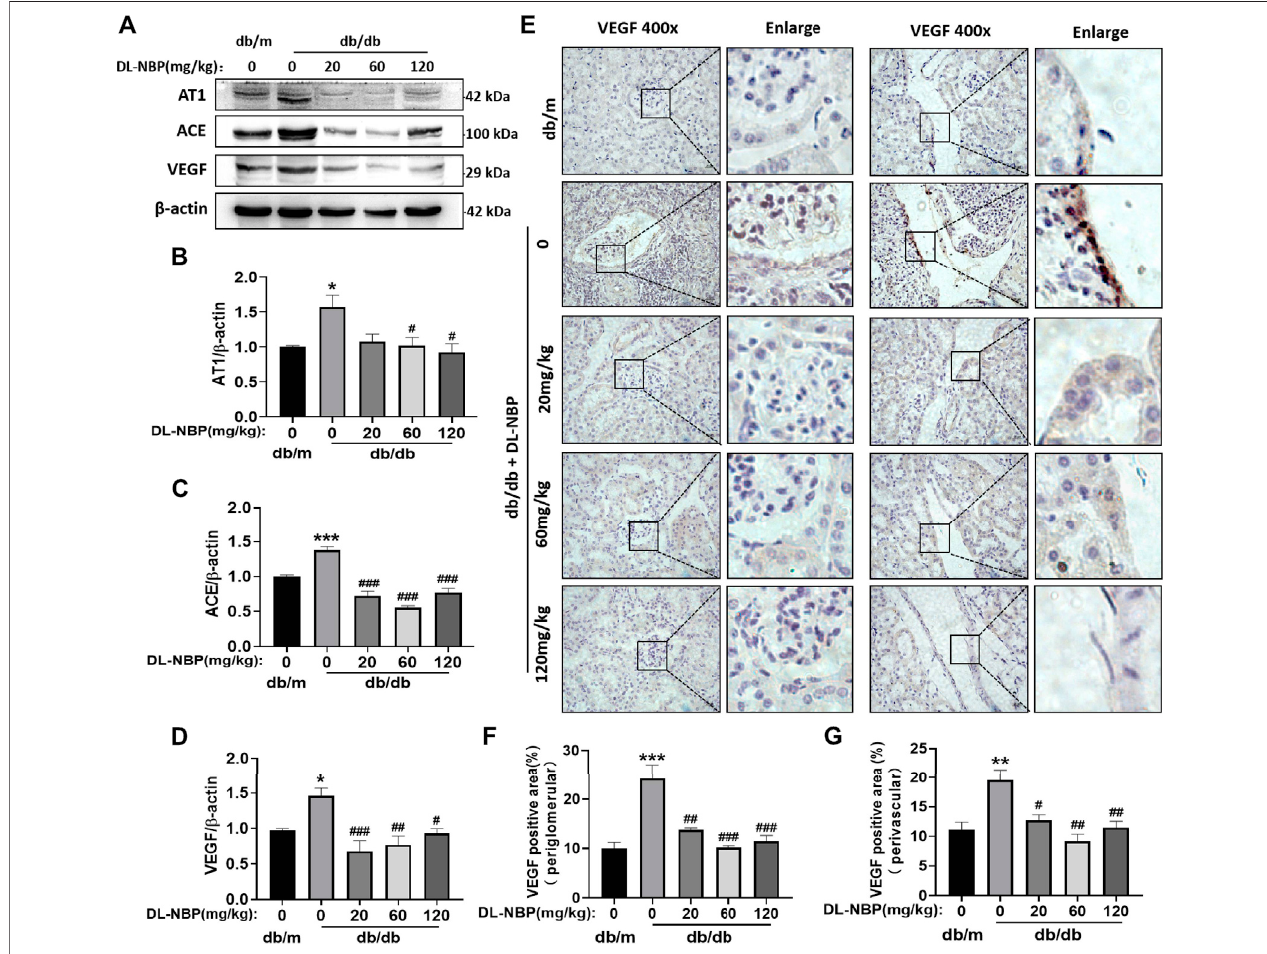
FIGURE 7 | DL-NBP restores the function of RAS and blocks VEGF overexpression. (A – D) Western blotting and quanti fi cation analysis of AT1, ACE, and VEGF in kidney of mice from each group ( n (cid:2) 3). Protein expression was normalized to the expression of β -actin. (E – G) Immunohistochemical staining of VEGF (brown positive point) inkidney ofmice fromeach group(original magni fi cation × 400) ( n (cid:2) 3). Scalebar (cid:2) 20 μ m.Dataare presented asmean ± SEM; * p < 0.05, ** p < 0.01, *** p < 0.001 vs. db/m control; # p < 0.05, ## p < 0.01, ### p < 0.001 vs . db/db mice. AT1, angiotensin II-related proteins angiotensin II receptor type 1; ACE, angiotensin II generating enzyme; VEGF, vascular endothelial growth